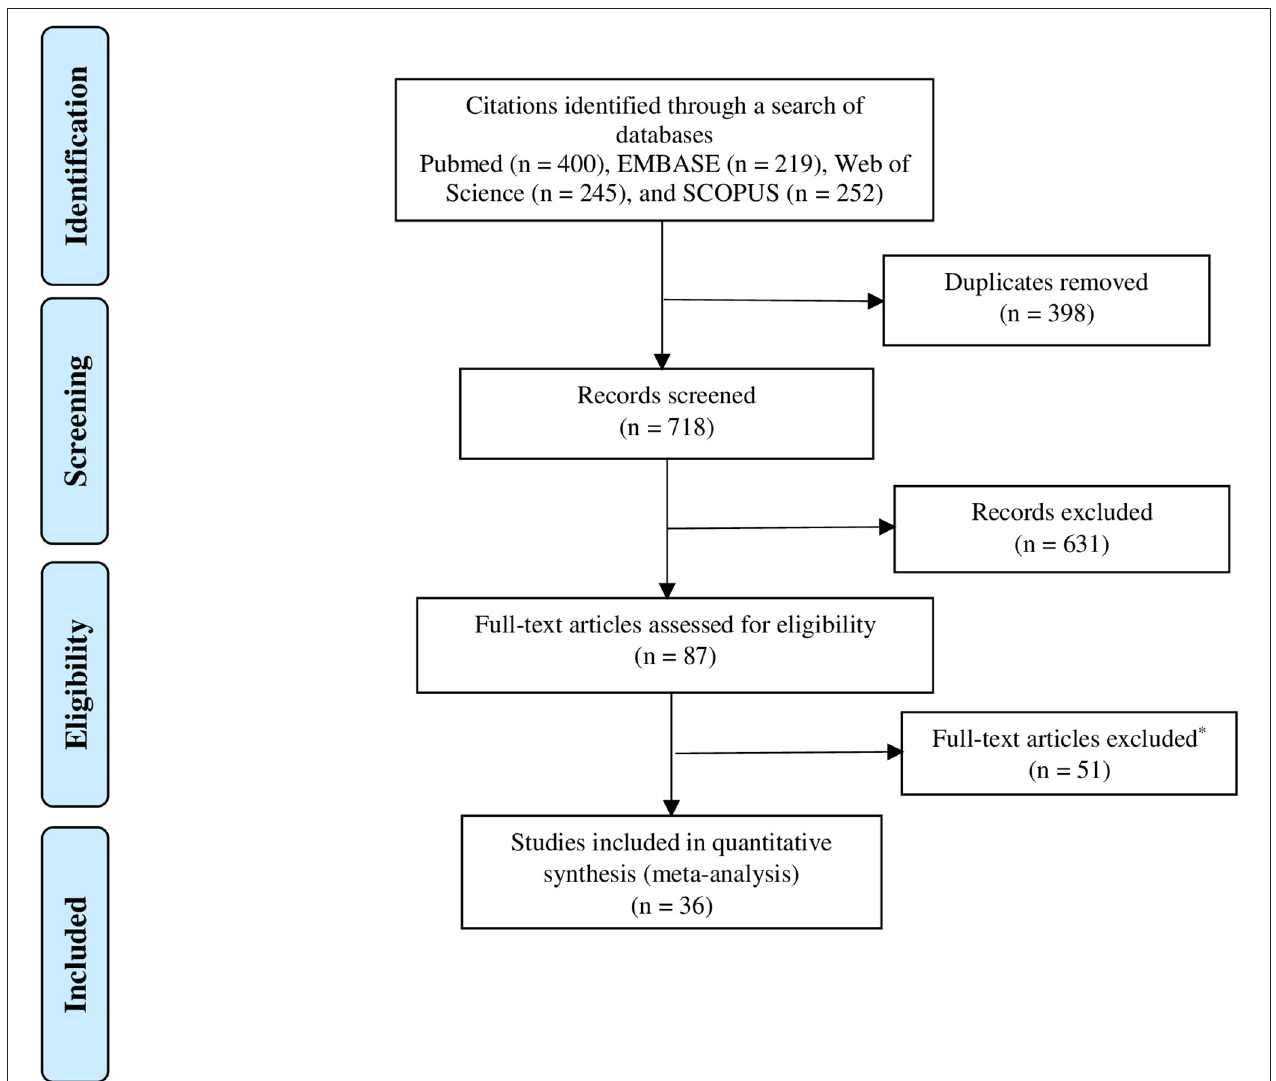
FIGURE 1 | PRISMA flow chart of study